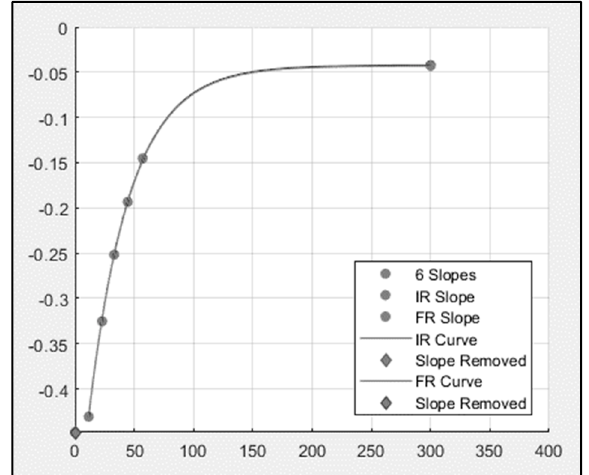
Figure 3. MatLab curve fit. The six slopes from one six-cuff trial were plotted in MatLab and fit to an exponential curve at a steady baseline. The resulting rate constant (Rc) is proportional to mitochondrial capacity. Slopes are measured as mitochondrial rate capacity (1/min) and Rc = 1.61.